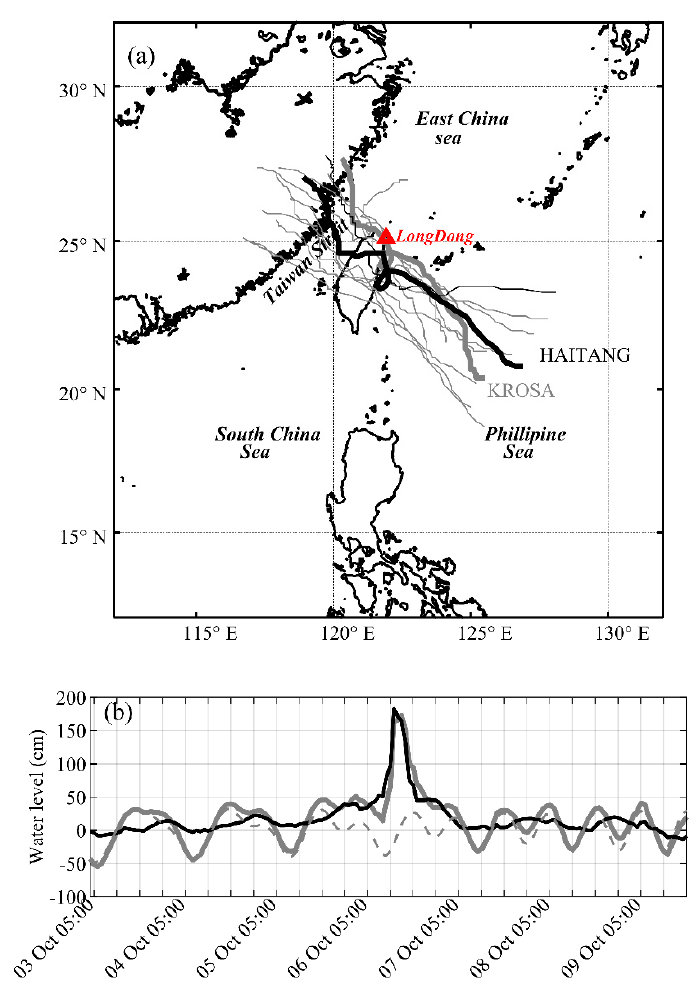
Figure 1. ( a ) Tracks of selected historical typhoons (2005–2014) and location of Longdong station; ( b ) total water level, astronomical tide, and storm surge deviation at Longdong during Typhoon Krosa.